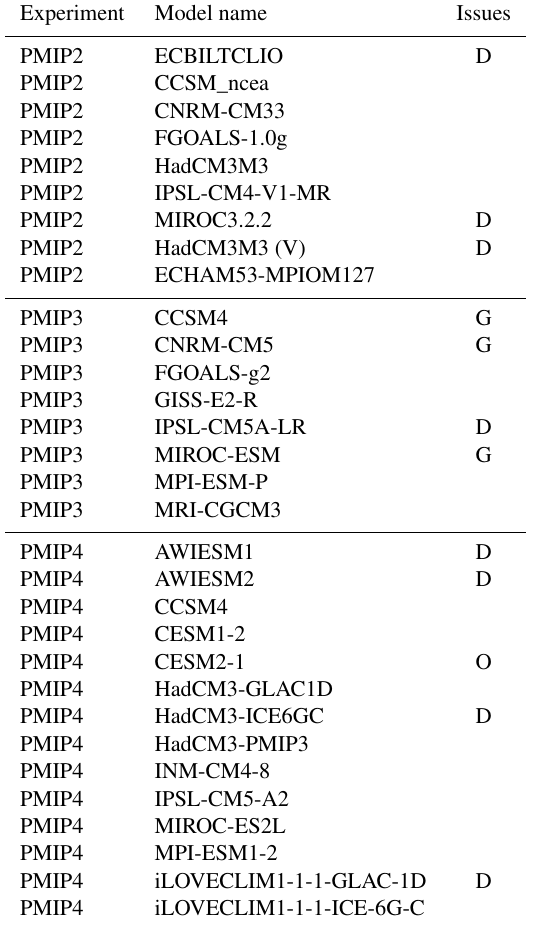
Table 1. Models available for the LGM reconstruction. G indicates removal for gridding problems. D indicates removal for duplica- tion/similarity and O indicates removal as an outlier. PMIP2 data were sourced from PMIP modellers (1998), PMIP3 data from PMIP modellers (2017) and PMIP4 data from Peterschmitt, and PMIP modellers